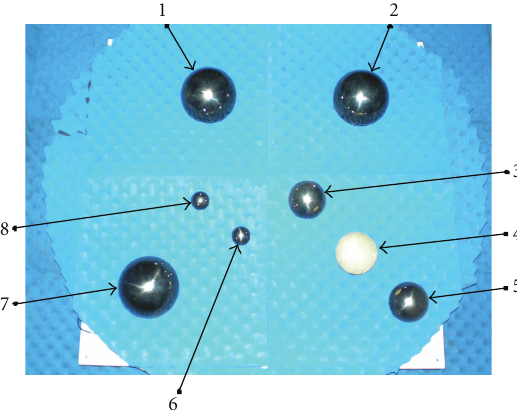
Figure 16: Experimental setup used to test monostatic (MS), quasimonostatic (QMS), and bistatic (BS) SWISAR algorithms, and the basis for equivalent simulated